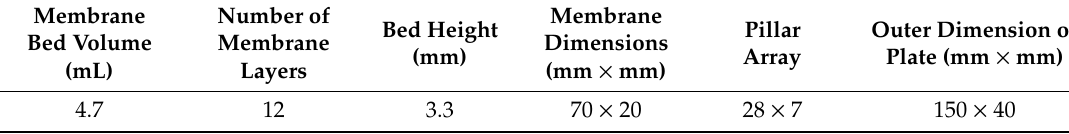
Figure 1. Diagram of a laterally-fed membrane chromatography (LFMC) device. Table 1. Design details of the LFMC device.